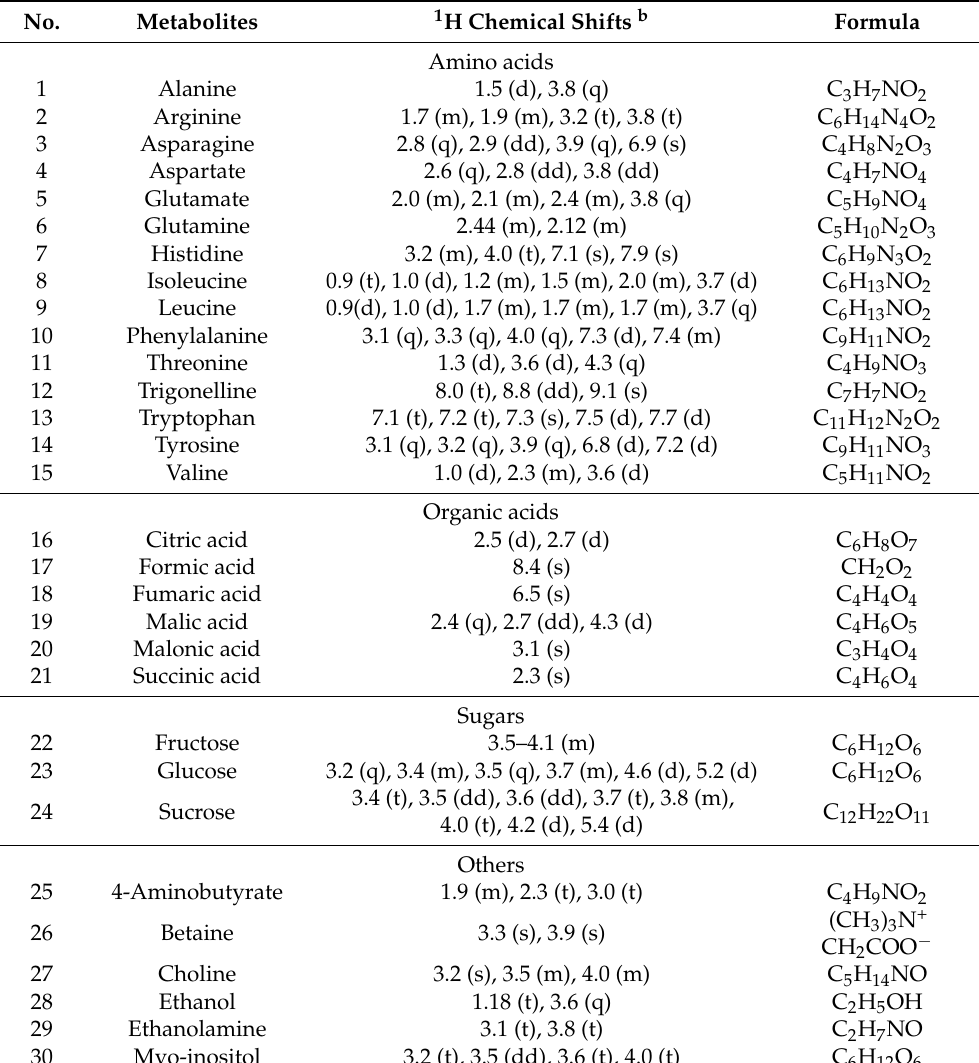
Table 2. Metabolites and 1 H chemical shifts identified by 800 MHz 1 H NMR a